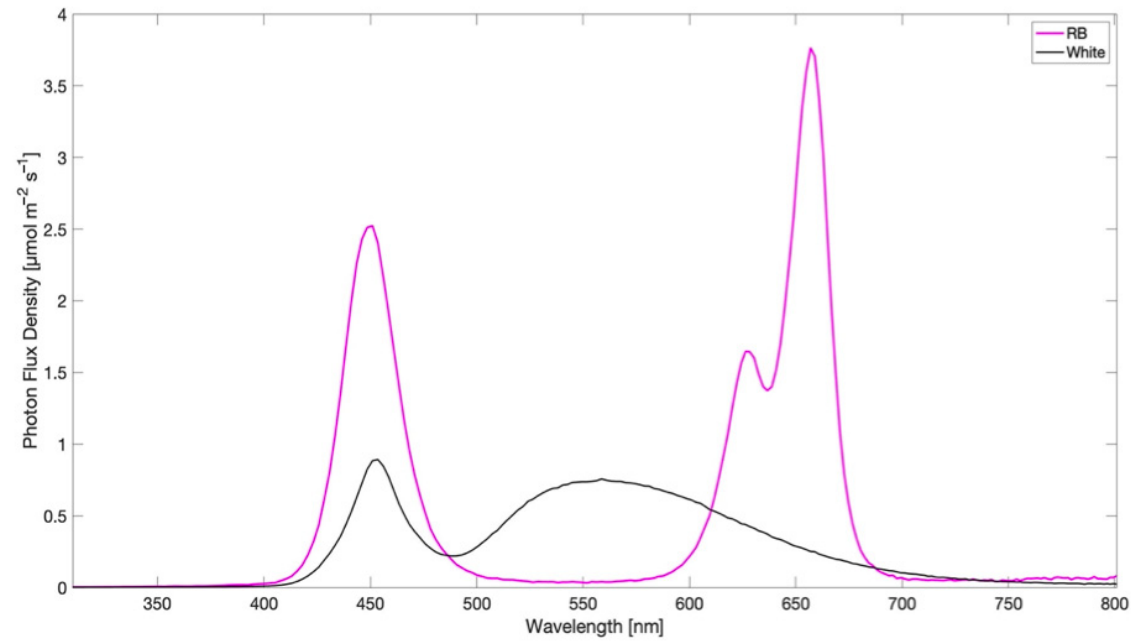
Figure 6. Light spectra set-up in the growth chamber: broad-spectrum white (W) and red-blue light (RB). Emission peaks for Red at 620 and 660 nm, emission peak for Blue at 460 nm).